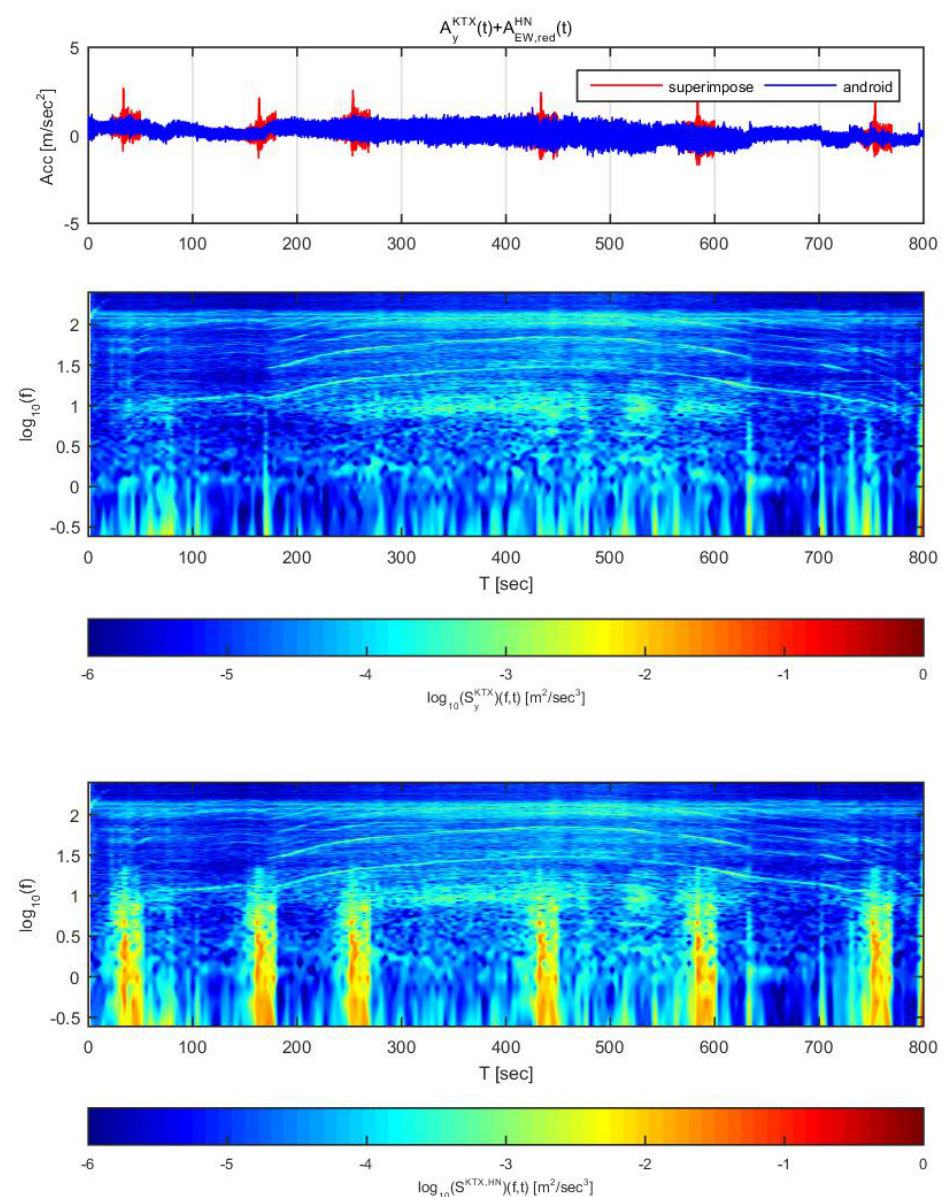
Figure 19. Combination of Korea Train Express (KTX) transverse direction data and Hachinohe east-west direction data (adjusted to 2 m / s 2 ).